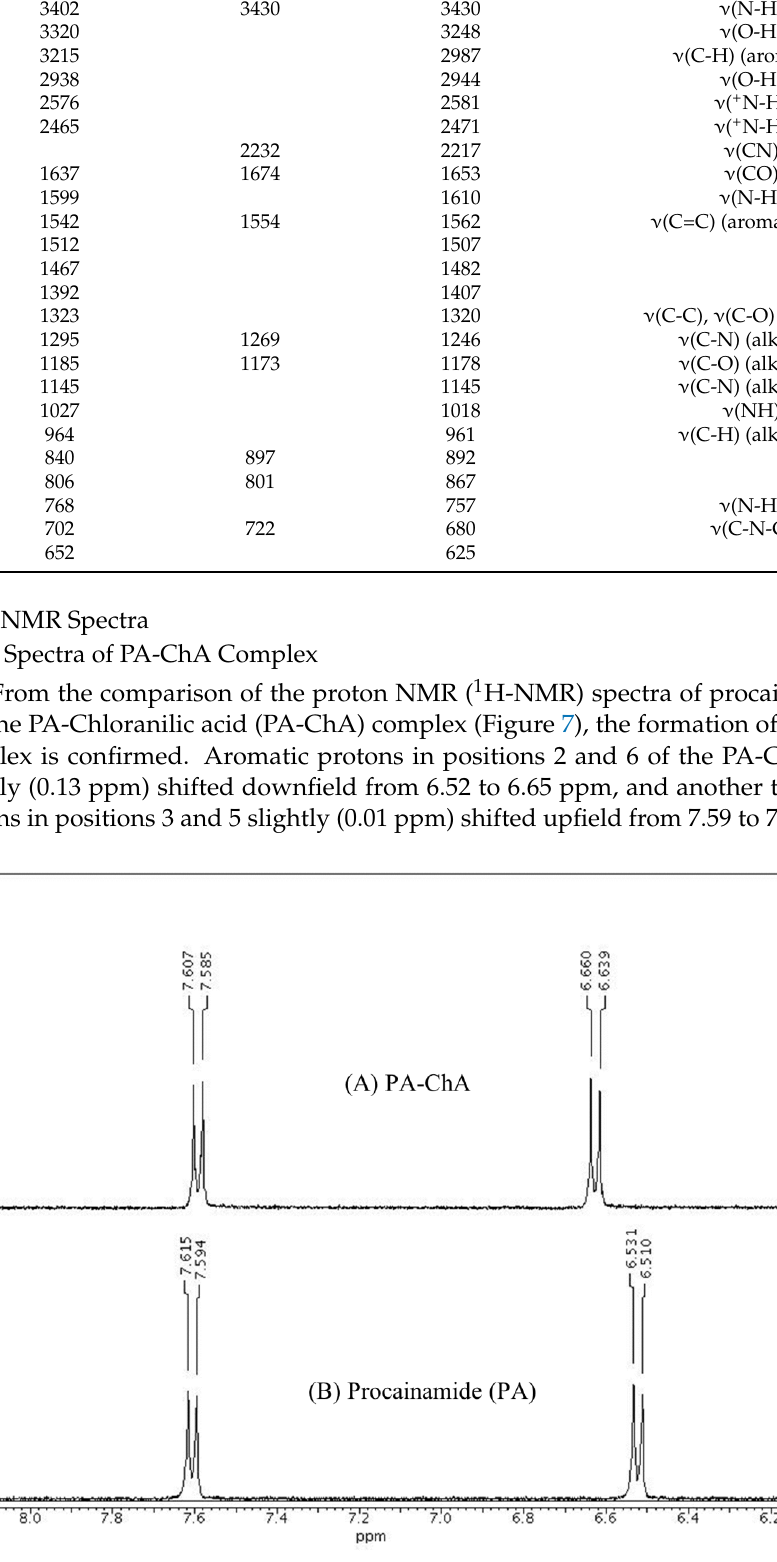
Figure 7. Comparison of proton-NMR ( 1 H-NMR) spectra of Procainamide and Procainamide-ChA complex: ( A ) aromatic region of Procainamide-ChA complex; ( B ) aromatic region of Procainamide (PA).